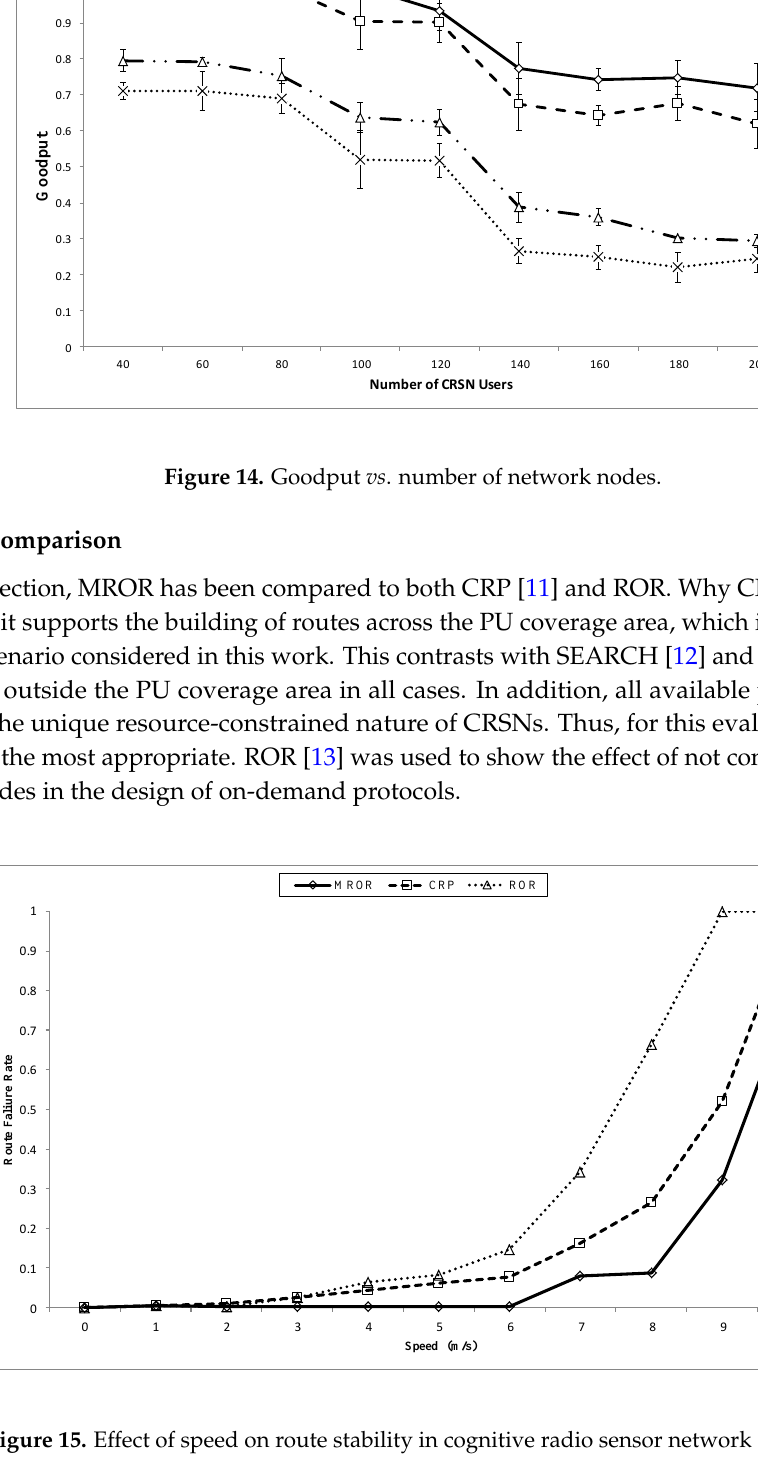
Figure 15. Effect of speed on route stability in cognitive radio sensor network